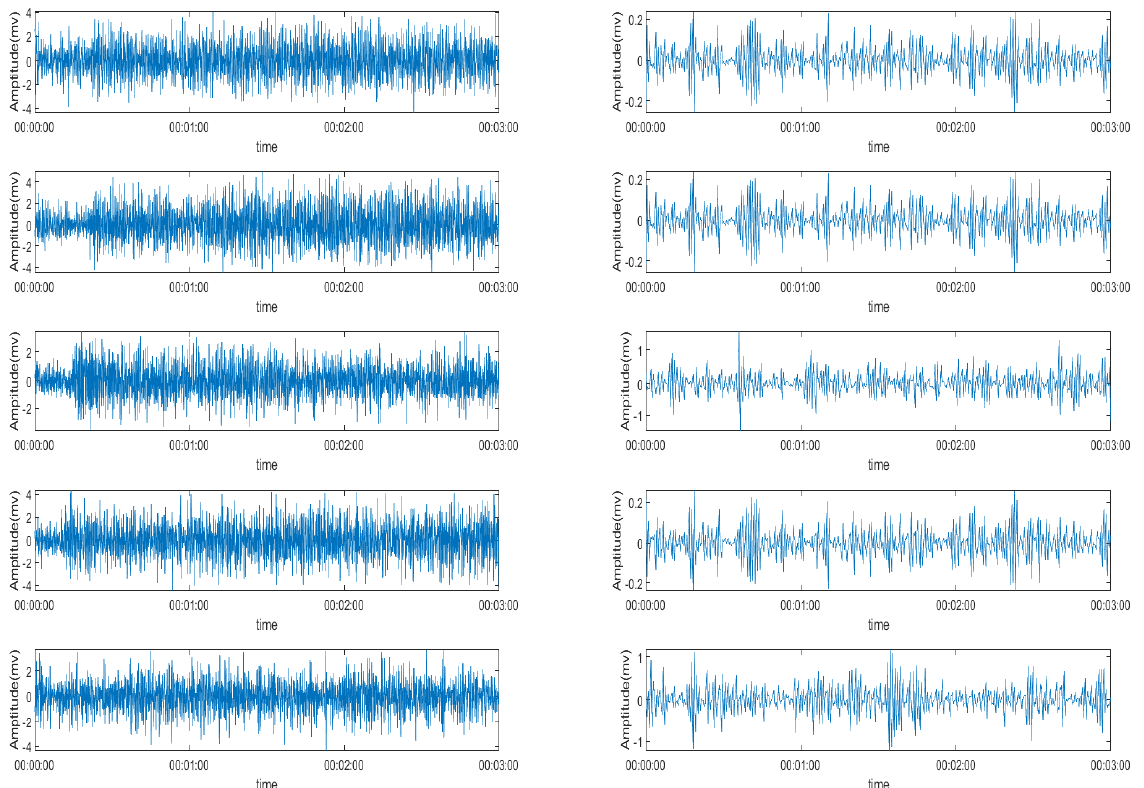
Figure 8. The ICA decomposition signals.